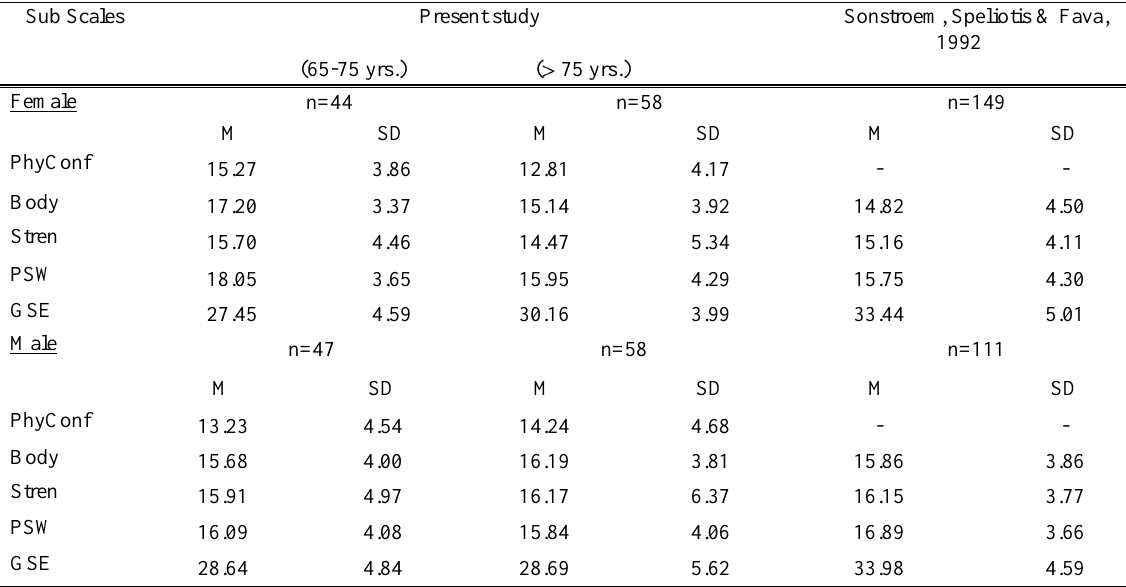
PhyConf – Physical Confidence; Body – Body Attractiveness; Stren – Physical Strength; PSW – Physical Self Worth; GSE – Global